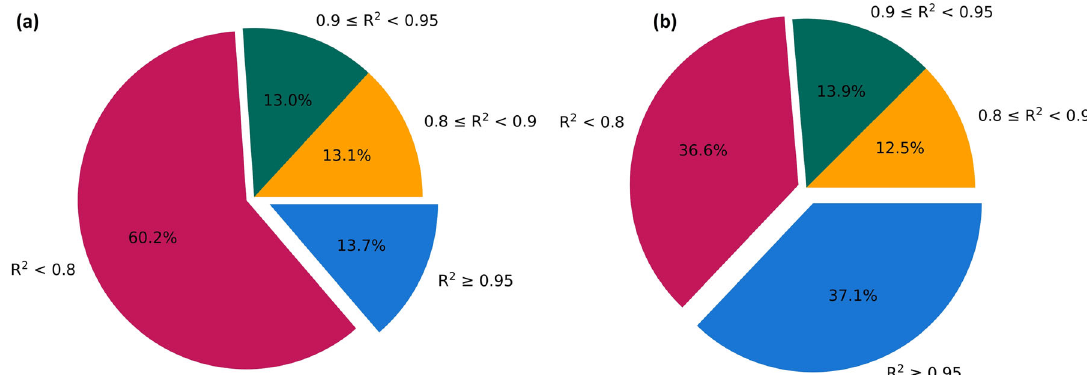
Fig. 4 The number of peptides for which the coef fi cient of determination (R2) is 0.95 or higher has more than doubled when using d2ome + (two mass isotopomer approach). Shown are the pie charts of detailed percentages of the results turnover rates from d2ome ( a ) and d2ome + ( b ) approaches. The percentages of quanti fi ed peptides with respect to four different R 2 intervals are shown. The percentage of peptides for which R 2 ≥ 0.95 (blue color) has increased from 16 to 40%. This group has become the largest category of peptides after the theoretical fi t using the monoisotopic RIAs obtained from the ratios of two mass isotopomers. The percentages of peptides with R 2 < 0.8 (red color) decreased by 24%. The number of peptides in the other two categories remained unchanged.